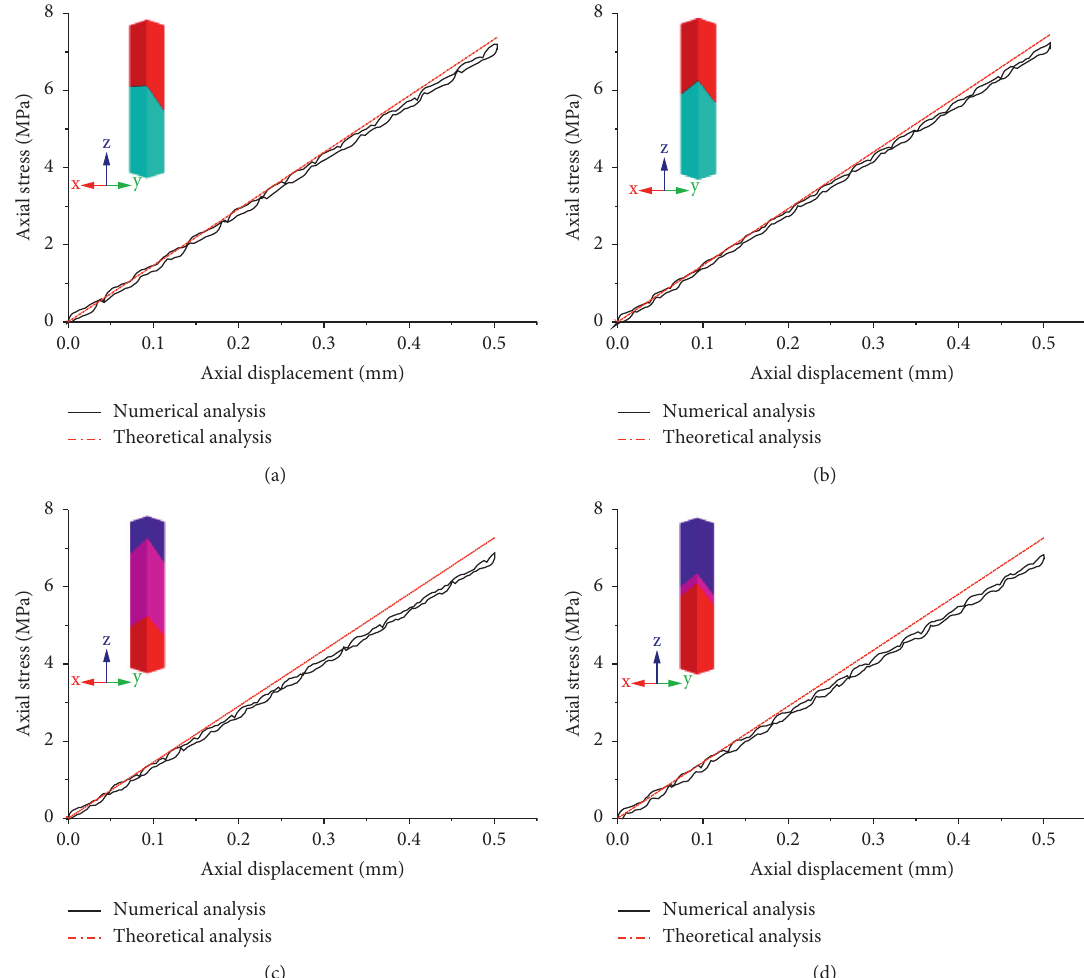
Figure 8: Comparison of numerical and theoretical results under different conditions with the coal with joints at H � 6m. (a) α � 45 ° , β � 0 ° and n � 1. (b) α � 45 ° , β � 45 ° and n � 1. (c) α � 45 ° , β � 45 ° and n � 2 (joints located at two ends of the model). (d) α � 45 ° , β � 45 ° and n � 2 (joints located in the middle of the model).